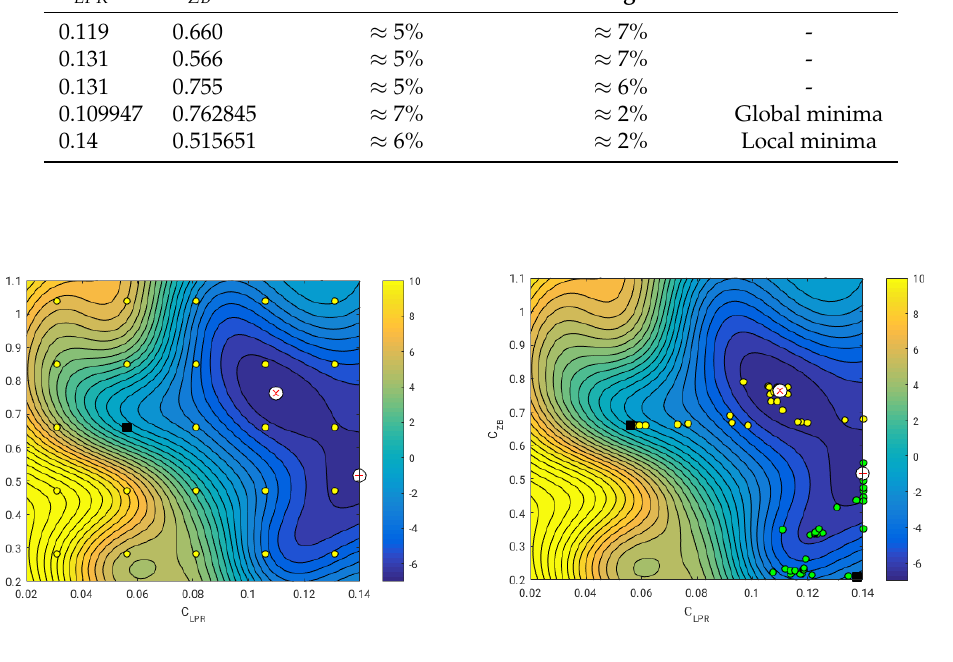
Figure 13. Left: the × symbol represents the global minimum, and the + symbol represents the local minimum. The square represents the starting geometry and the circles represent the new geometries. Right: the two squares represent two different starting points of the optimization algorithm. The yellow circles represent the path followed by the gradient-based algorithm when starting from the topmost position, whereas the green circles represent the path followed by the gradient-based algorithm when starting from the bottom-most position. In both images, the color scale represents the resistance variation in reference to the original geometry (where negative values indicate resistance reduction, and positive values indicate resistance